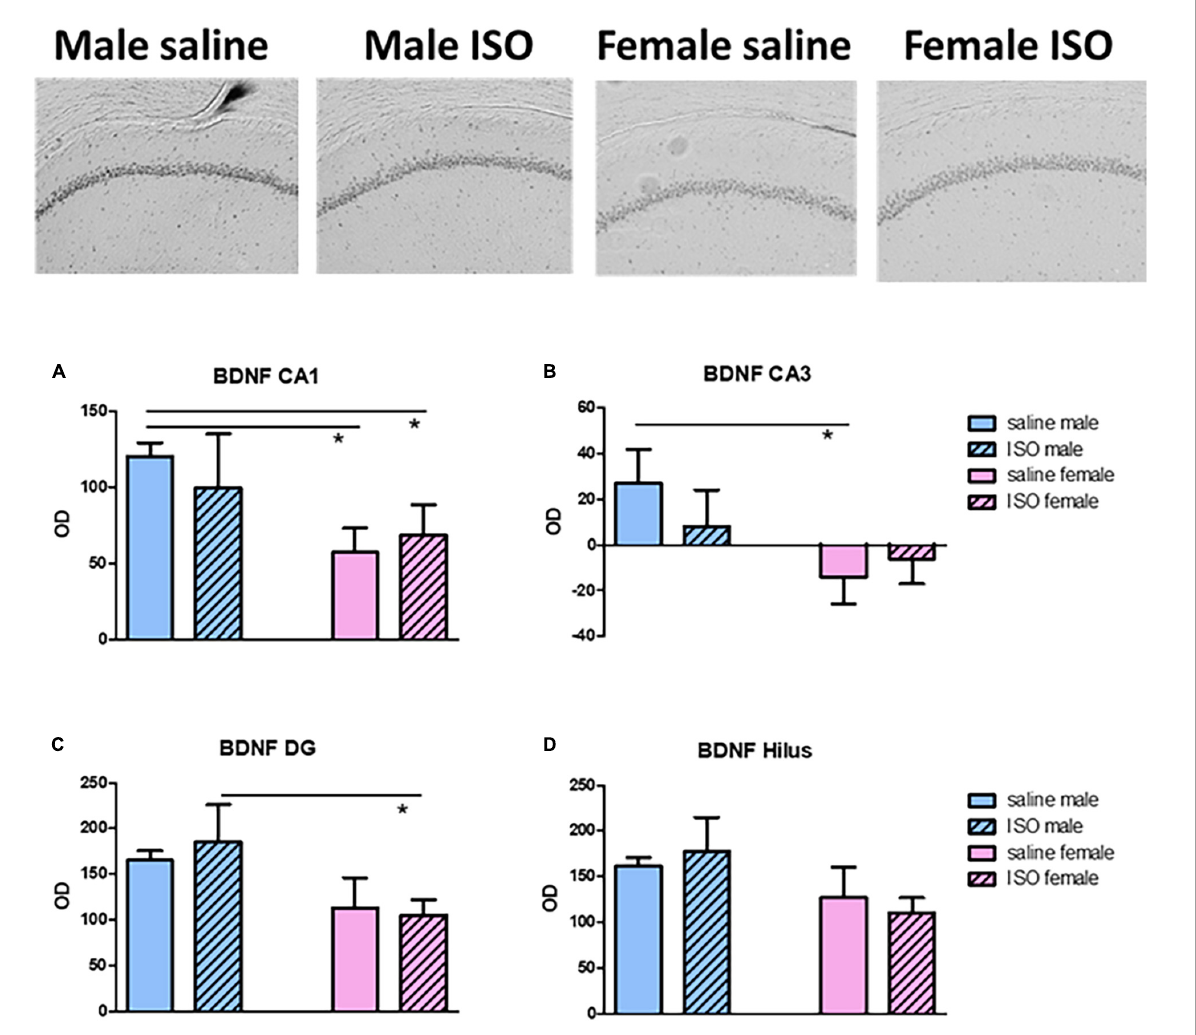
FIGURE5 Top: typical pictures of the Brain-derived neurotrophic factor (BDNF) staining in the CA1 area of the different experimental groups. (A–D) BDNF expression, expressed as relative optical density (OD), in the different areas of the hippocampus, CA1, CA3, dentate gyrus (DG) and Hilus, in the different experimental groups ( n = 8,5,6,10 in saline male, ISO male, saline female and ISO female rats, respectively). ISO, isoproterenol. *Significant difference between indicated groups.